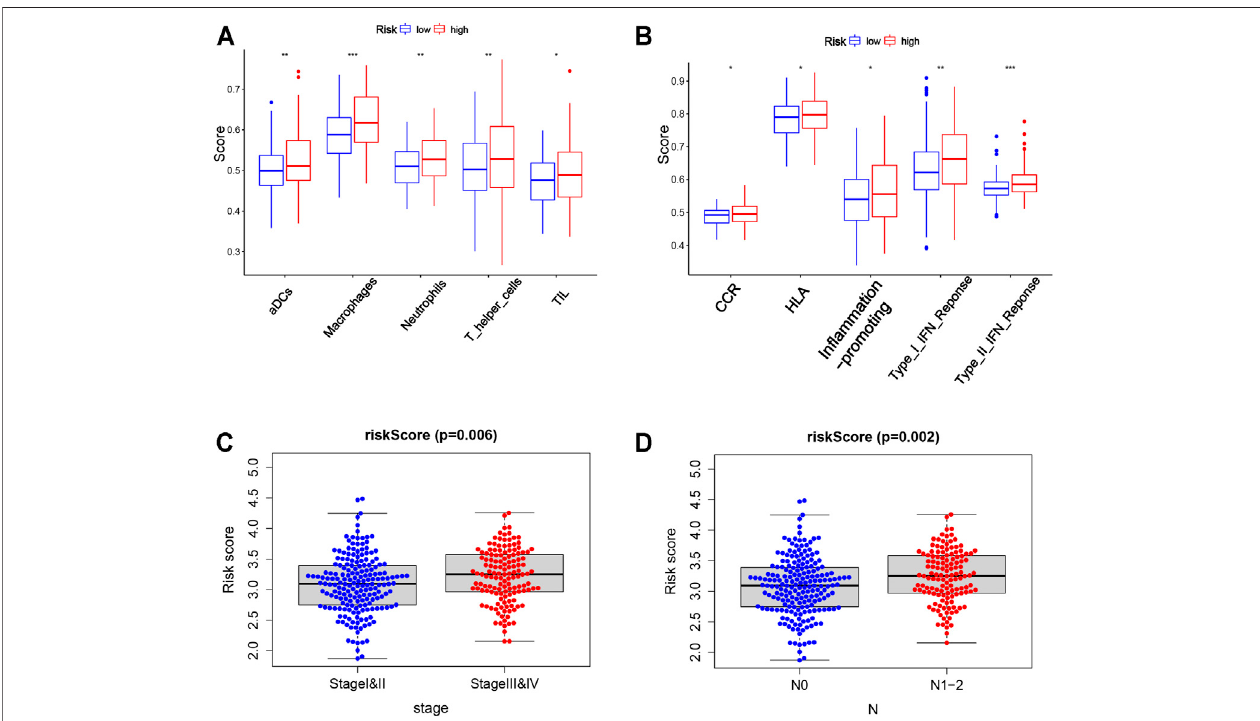
FIGURE7| Correlationoftheriskscorewithclinicopathologicalfeaturesandimmunecellsaswellasimmunefunction. (A,B) Comparisonoftheenrichmentscores of5typesofimmunecellsand5immune-relatedfunctionsbetweenlow-(bluebox)andhigh-risk(redbox)groupsintheTCGAcohort. (C,D) Correlationbetweentherisk score and clinicopathological features. Stage, tumor – node – metastasis (TNM) stage; N,